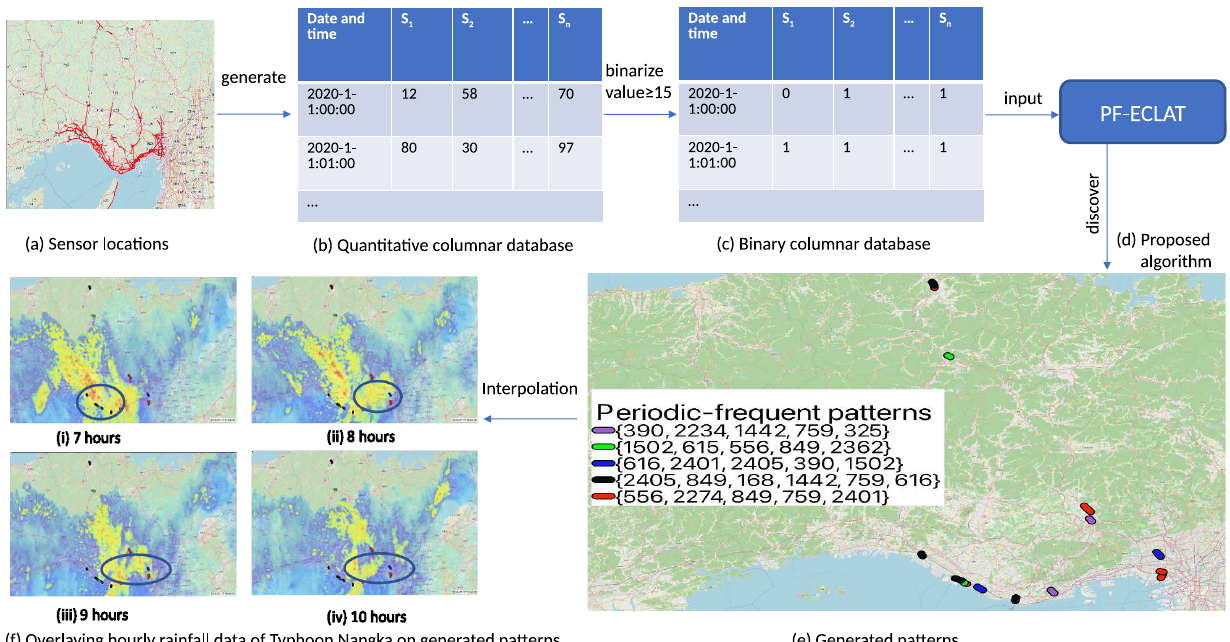
Figure 12. Finding periodic-frequent patterns in the Congestion database. The terms ‘ s 1 ’, ‘ s 2 ’, · · · ‘ s n ’ represents ‘road sensor